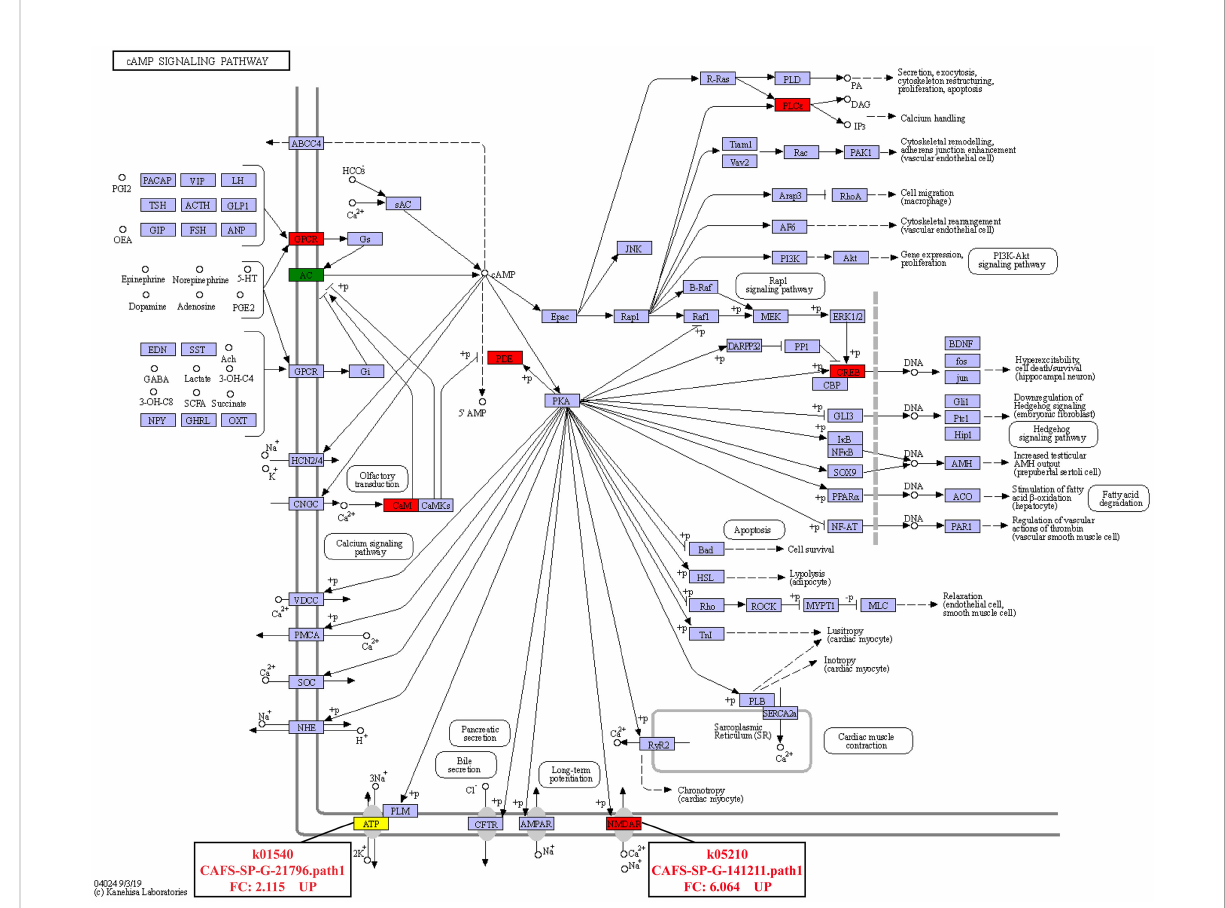
FIGURE 5 Pathway analysis of cAMP signaling pathway (ko04024) in